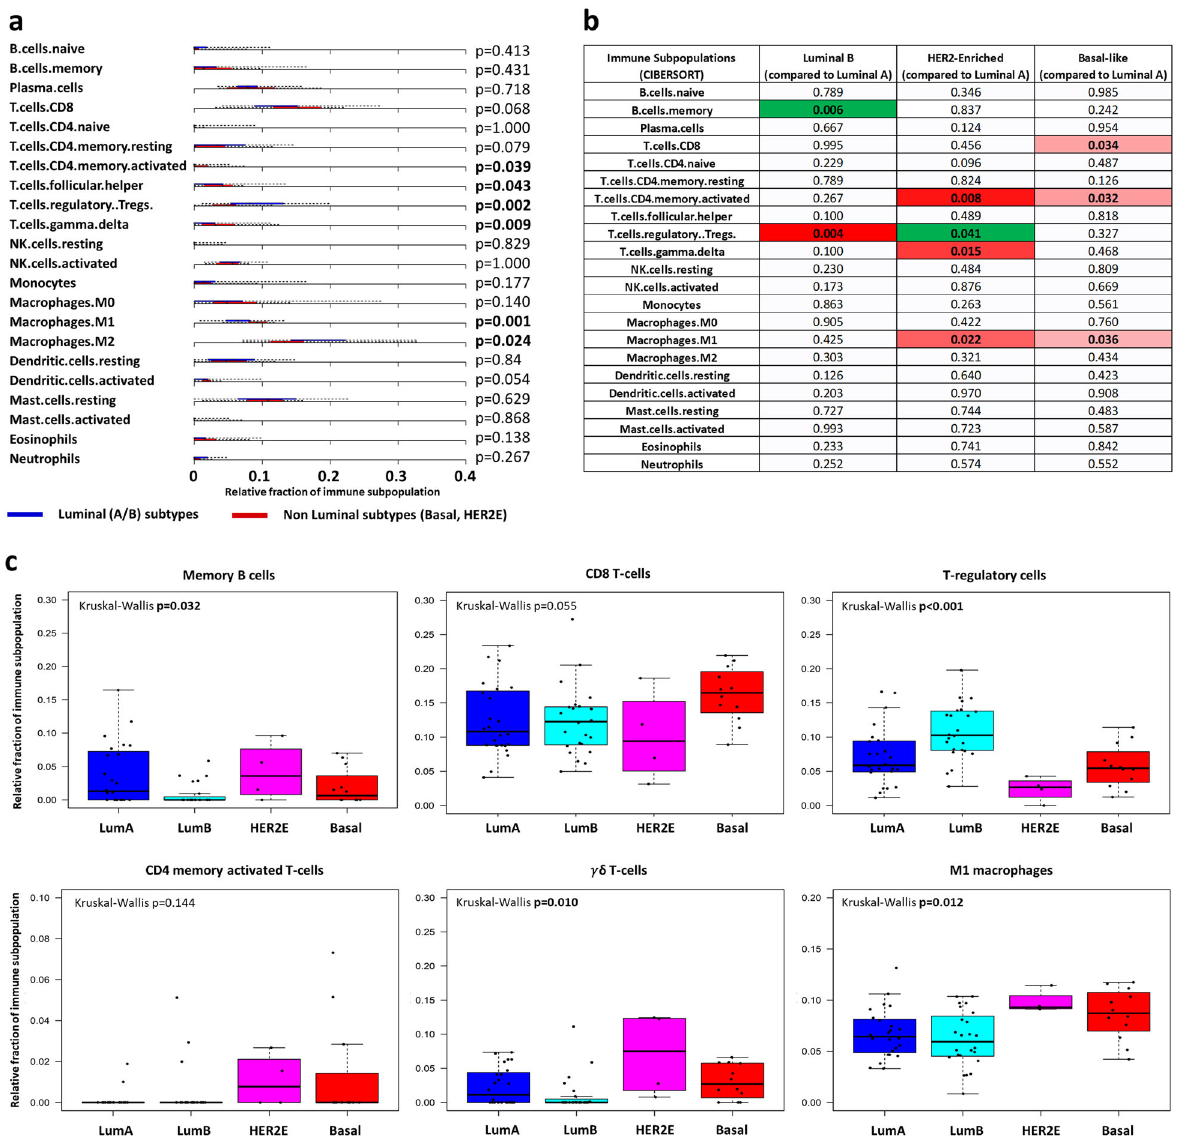
Fig. 2 Comparison of relative fraction of each immune cell subpopulation across intrinsic subtypes. a Boxplots representing distribution of relative immune cell fraction for each immune cell subpopulation in Luminal (A and B, blue) and non-Luminal (HER2-Enriched and Basal-like, red) tumors. b Heatmap showing Mann – Whitney U p -values for the comparison of the distribution of immune cell fractions in each intrinsic subtype as compared to Luminal-A tumors (red: higher fraction than in Luminal-A tumors; green: lower fraction than in Luminal-A tumors). c Boxplots representing distribution of relative fraction of each immune cell across intrinsic subtypes for immune cell subpopulations presenting signi fi cant differences in distribution. Boxplot legend: centre line: median; bounds of box: interquartile range (IQR); whiskers: highest and lowest value excluding outliers (Q3 + 1.5*IQR to Q1-1.5*IQR); markers beyond the whiskers: potential